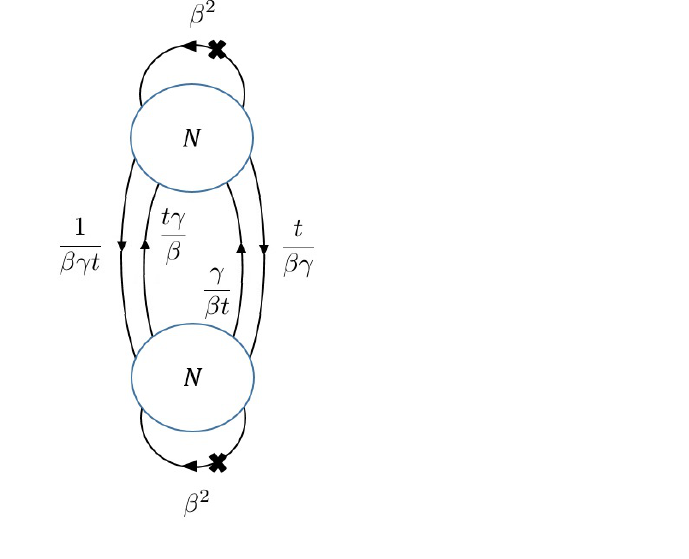
Figure 4 . The quiver diagram for the 4d class S 2 theory corresponding to a torus with (cid:13)ux (1 ; 0 ; 0). Next to the (cid:12)elds are their charges summarized through fugacities. We use mostly standard notation except for two points: lines from a group to itself represent N 2 hypermultiplets forming the adjoint plus singlet representations of the group; we write an X over a (cid:12)eld to represent the fact that the baryon of that (cid:12)eld is (cid:13)ipped. The theory has a cubic superpotential for every triangle which can also be derived by considering the most general cubic superpotential that is gauge invariant and consistent with the symmetry allocation. There is also the superpotential term which is not generally cubic coming from the (cid:13)ipping. All (cid:12)elds, save the (cid:13)ipping (cid:12)elds, have the free R -charge 2 3